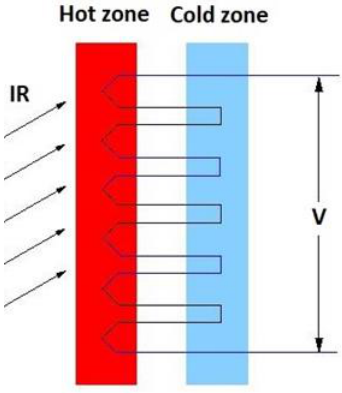
Figure 5. Scheme of a thermopile.